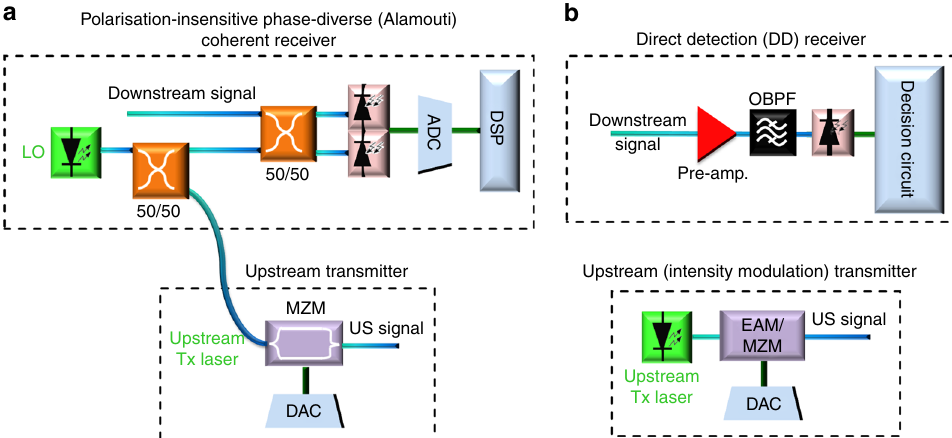
Fig. 9 The schematics of simpli fi ed coherent and direct detection ONU transceivers. a Proposed polarisation-independent coherent ONU transceiver enabled by Alamouti coding combined with heterodyne detection. b Typical intensity modulation/direct detection transceiver. Note that analogue processing using a decision circuit is suf fi cient to demodulate an OOK signal. EAM: electro-absorption modulator, MZM: Mach-Zehnder